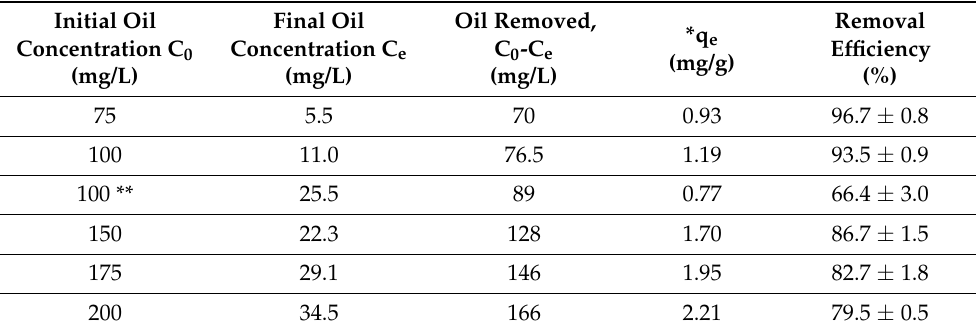
Table 2. Influence of initial oil concentration on the adsorption of emulsified diesel oil (DO) onto 3.0 g treated dosage at a contact time of 24 h.